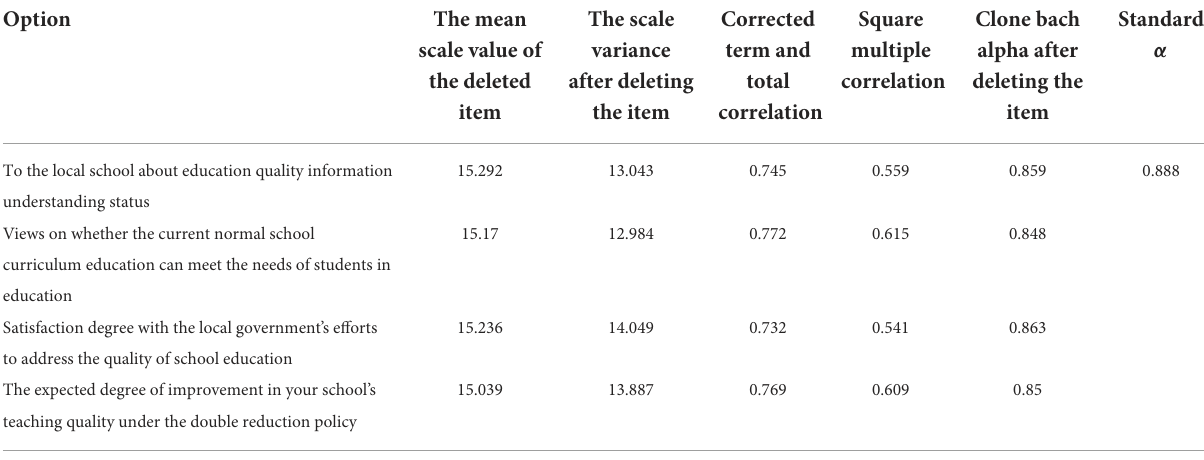
TABLE 4 Views on whether national education and training direction can be diversified under the double reduction policy. Option The mean